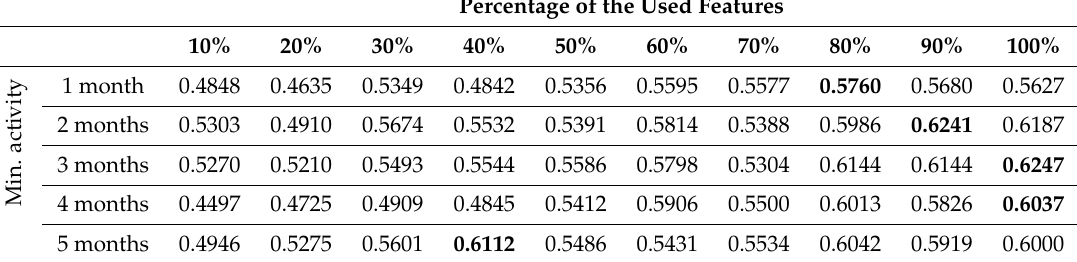
Table A3. F-score macro average for the Neural Network classification of two levels of the hierarchy in the manufacturing company dataset. The values which are bolded are the best results for a given minimum communication